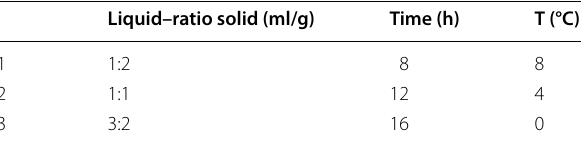
Table 2 Factors and levels of orthogonal test of precipita- tion